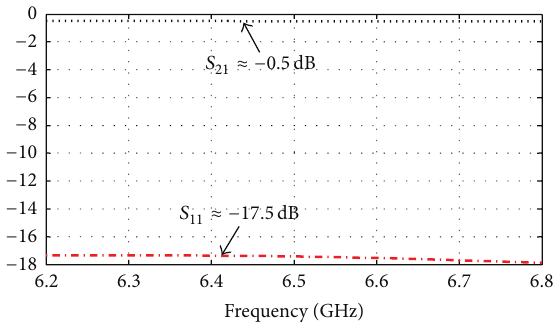
Figure 6: Simulated | S 11 | (dB) and | S 21 | (dB) associated with Figure 5; effects of discontinuities and SMA connector are